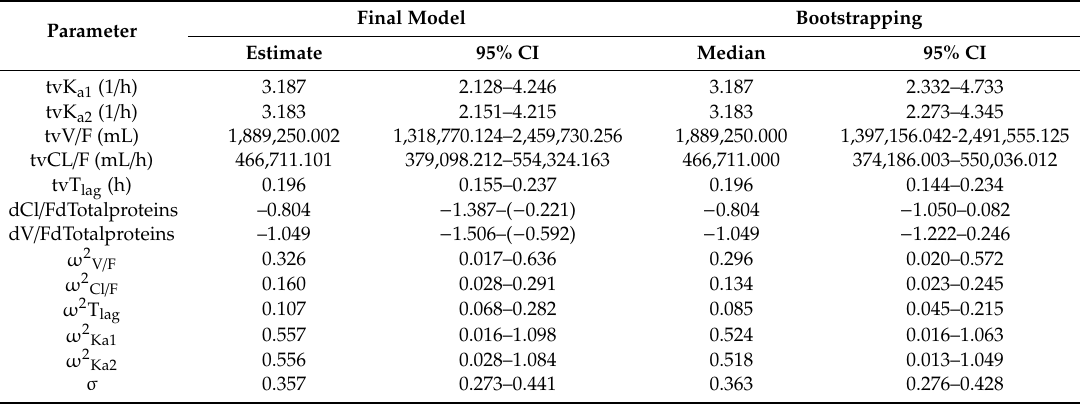
Table 7. Estimated population pharmacokinetic parameter values of tiropramide and bootstrap validation ( n = 1000).